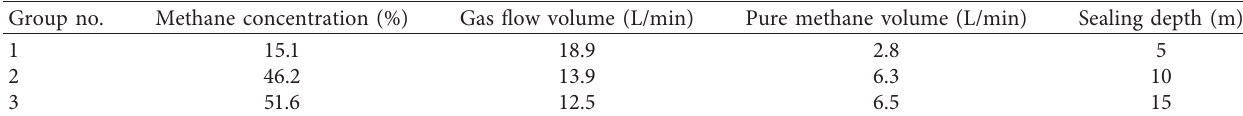
Table 6: Drainage results of each